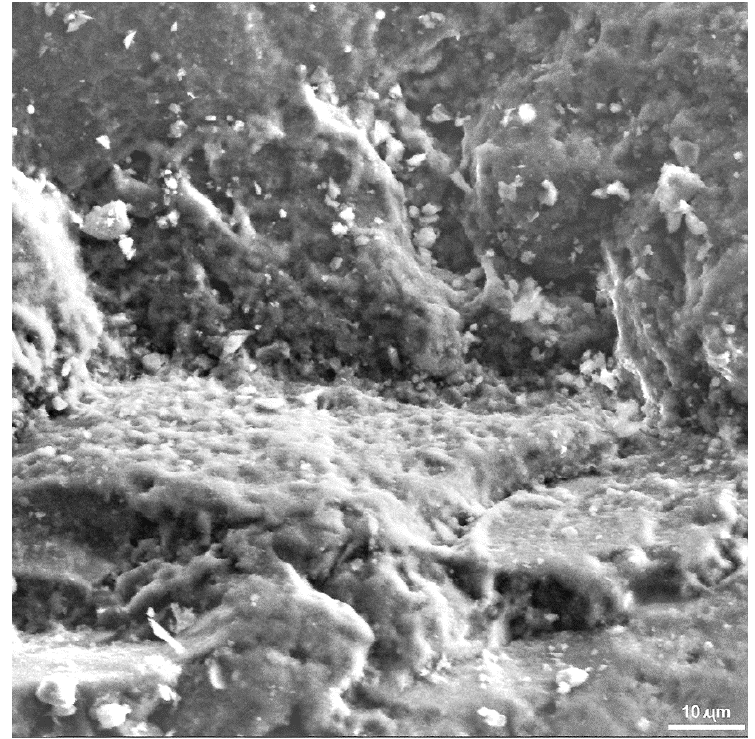
Figure 4. Texture of the crystalline quartz at high